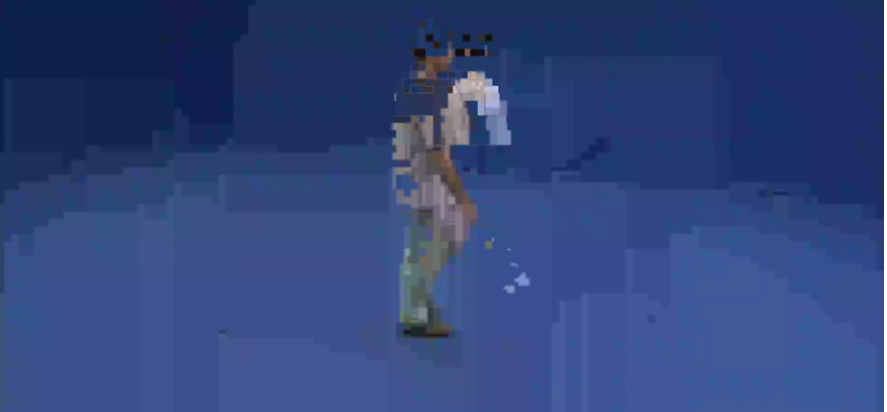
Figure 10. Frame of a video with a bitrate of 35 Kbps: Accuracy = 0.40.